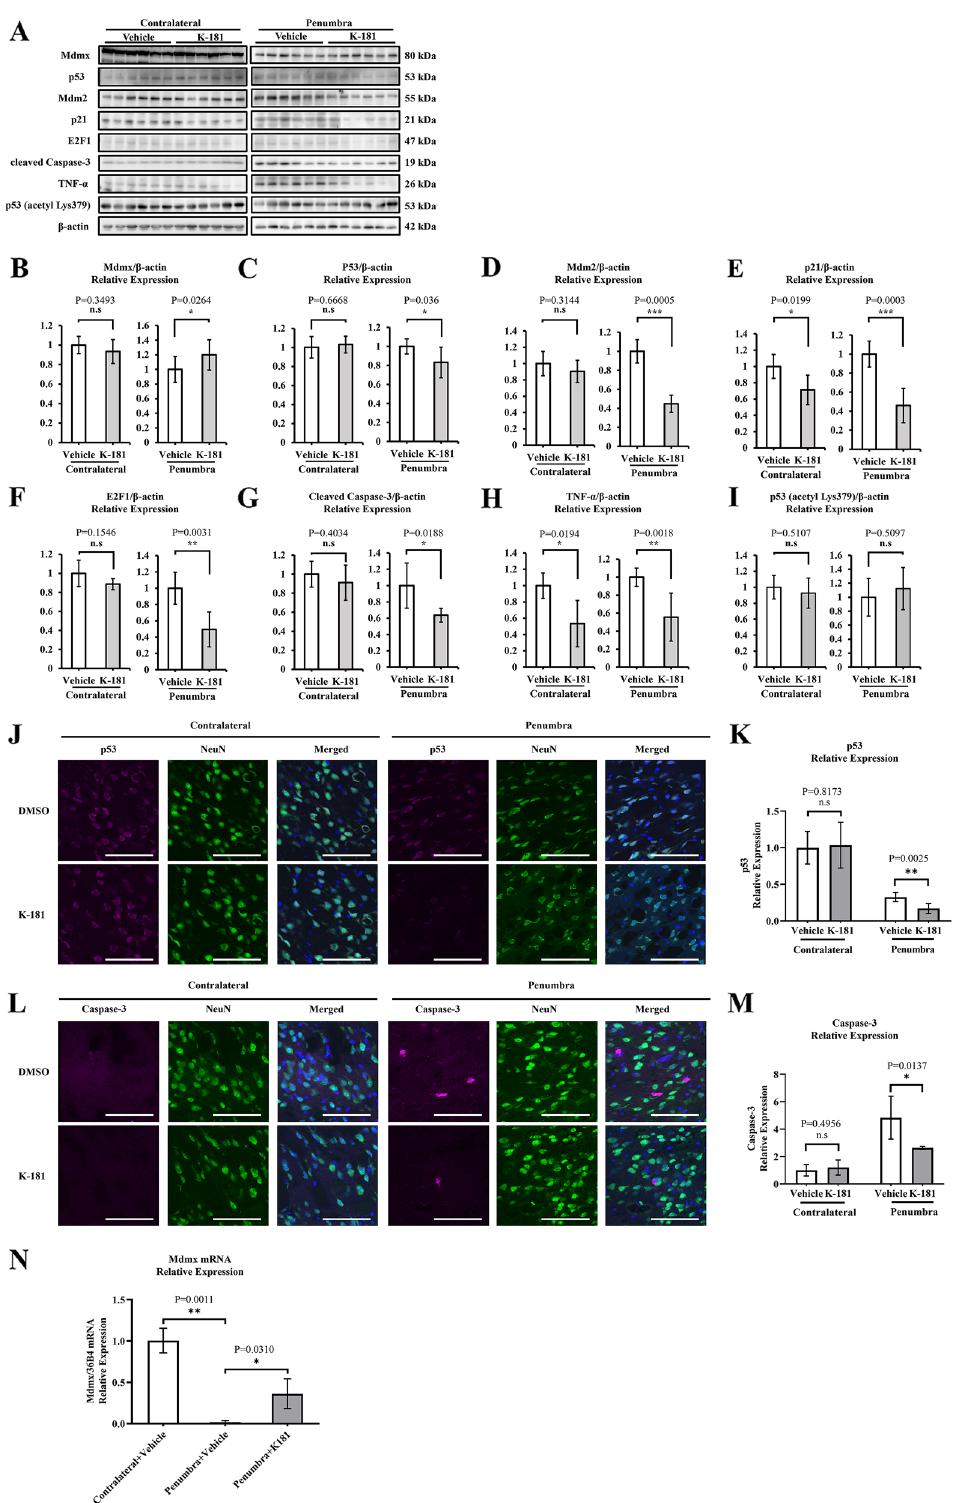
Figure 4. K-181 increases Mdmx expression under ischemic stroke in mice brains. ( A – I ) Western Blot images ( A ) and quantification of Mdmx ( B ), p53 ( C ), Mdm2 ( D ), p21 ( E ), E2F1 ( F ), cleaved Caspase-3 ( G ), TNF-α ( H ) and p53 (acetyl Lys379) ( I ) expression in vehicle and K-181 treated mice brains. ( J – K ) Representative immunostaining images ( J ) and quantification of p53 ( K ) in vehicle and K-181 treated mice brains. N = 6. Scale Bar = 100 μm. ( L – M ) Representative immunostaining images ( L ) and quantification of Caspase-3 ( M ) in vehicle and K-181 treated mice brains. N = 6. Scale Bar = 100 μm. ( N ) qPCR results of Mdmx mRNA levels in vehicle and K-181 treated mice brains. N =